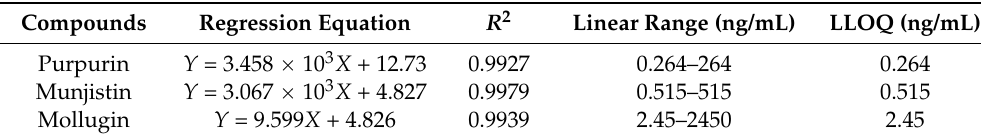
Table 2. The regression equations, linear ranges and LLOQs for the determination of the analytes in rat plasma.